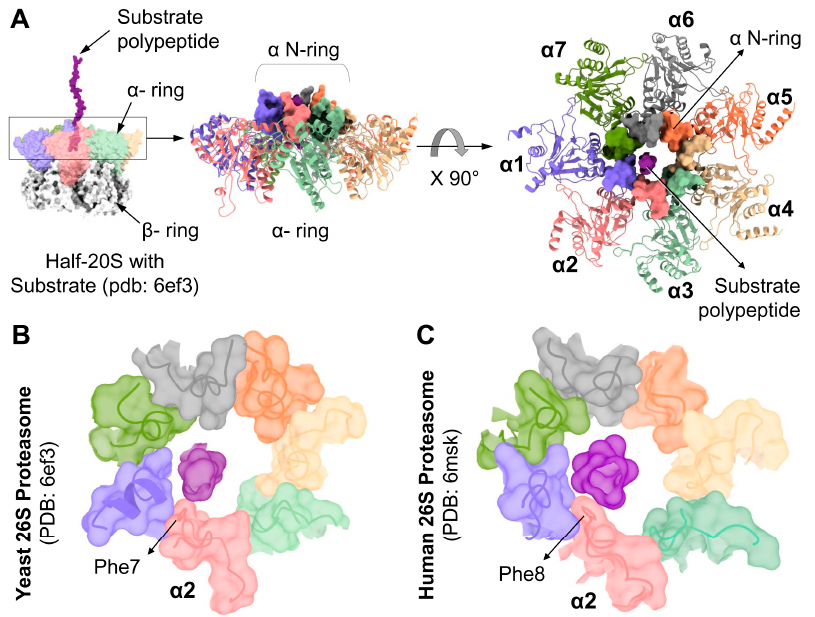
Figure 6. YD(X) motif of the α 2 subunit interacts with the substrate during translocation into the 20S-CP. ( A ) Left: Surface contour structure of substrate-engaged yeast proteasome (pdb:6ef3) showing the substrate polypeptide entering the α N-ring. Right: Top view of the α N-ring in surface presentation while engaged with the substrate polypeptide. Top views of the α N-ring in surface presentation from 26S proteasome model structures: Yeast, pdb:6ef3 ( B ), and Human, pdb:6msk ( C ), showing the substrate polypeptide interacting with the Phe residues of the YDF sequences in the corresponding α 2 subunits.